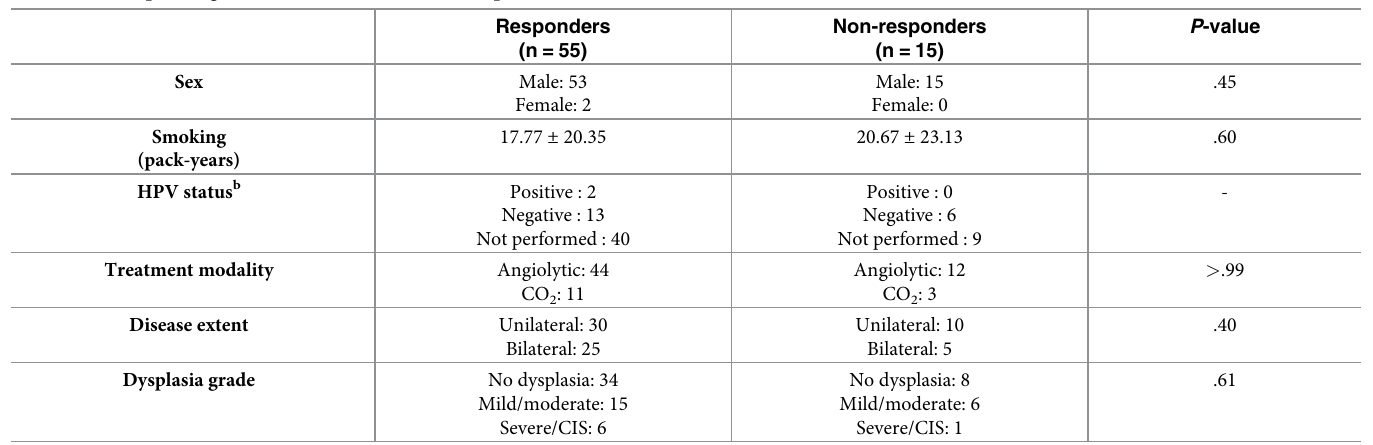
Table 2. Clinicopathologic factors related to treatment response a .